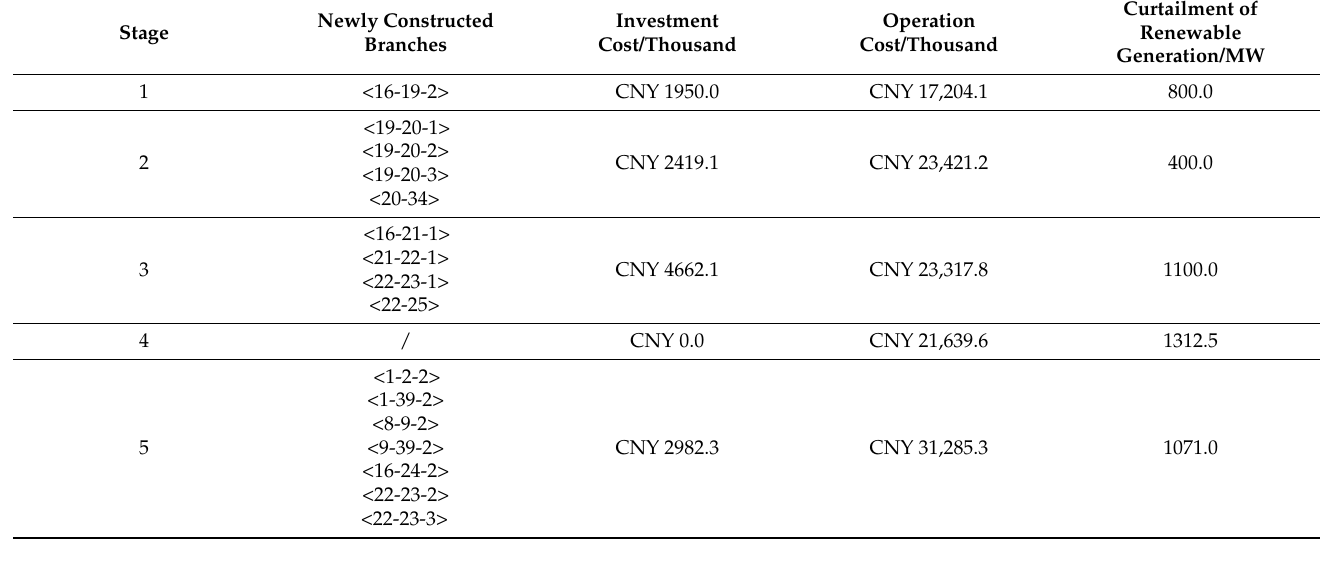
Table 2. The multi-period planning scheme based on the conventional model (Scheme 2).